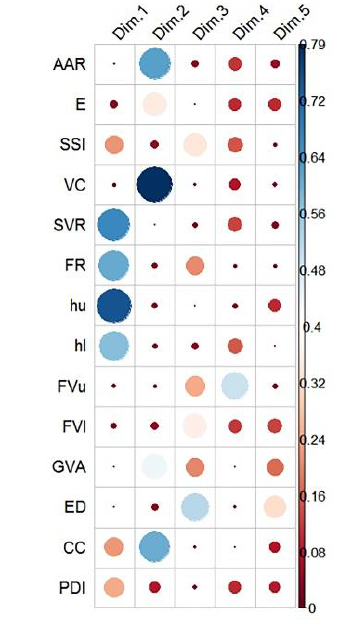
Figure 8. Principal component analysis (PCA).